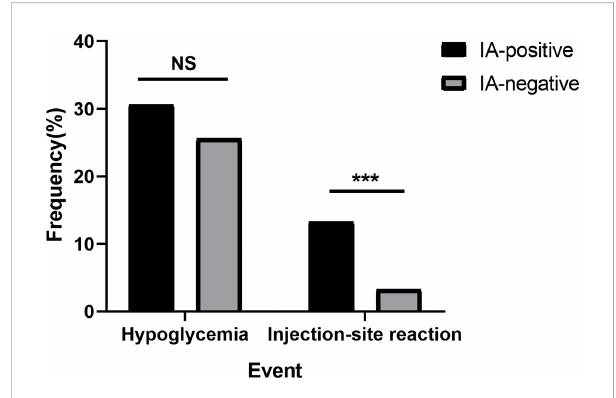
FIGURE 5 Frequency of hypoglycemia or injection-site reactions in the IA- positive group and IA-negative group. NS, no signi fi cance; *** P < 0.0001; injection-site reaction, referring to skin itching, local redness and swelling, ecchymosis, subcutaneous nodules, and